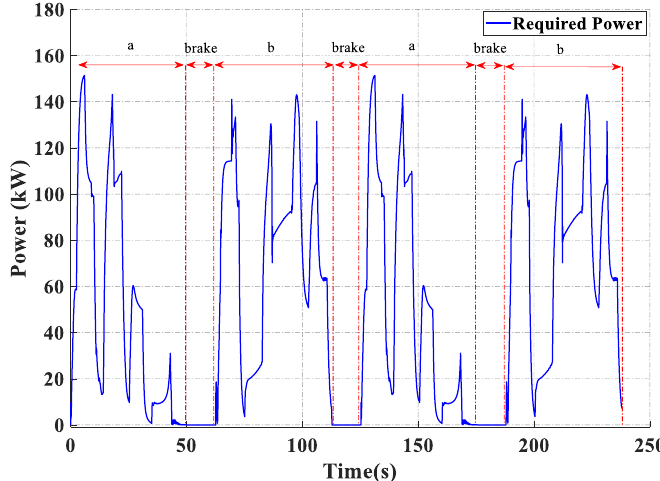
Figure 10. The required power of the excavator with two different working cycles.